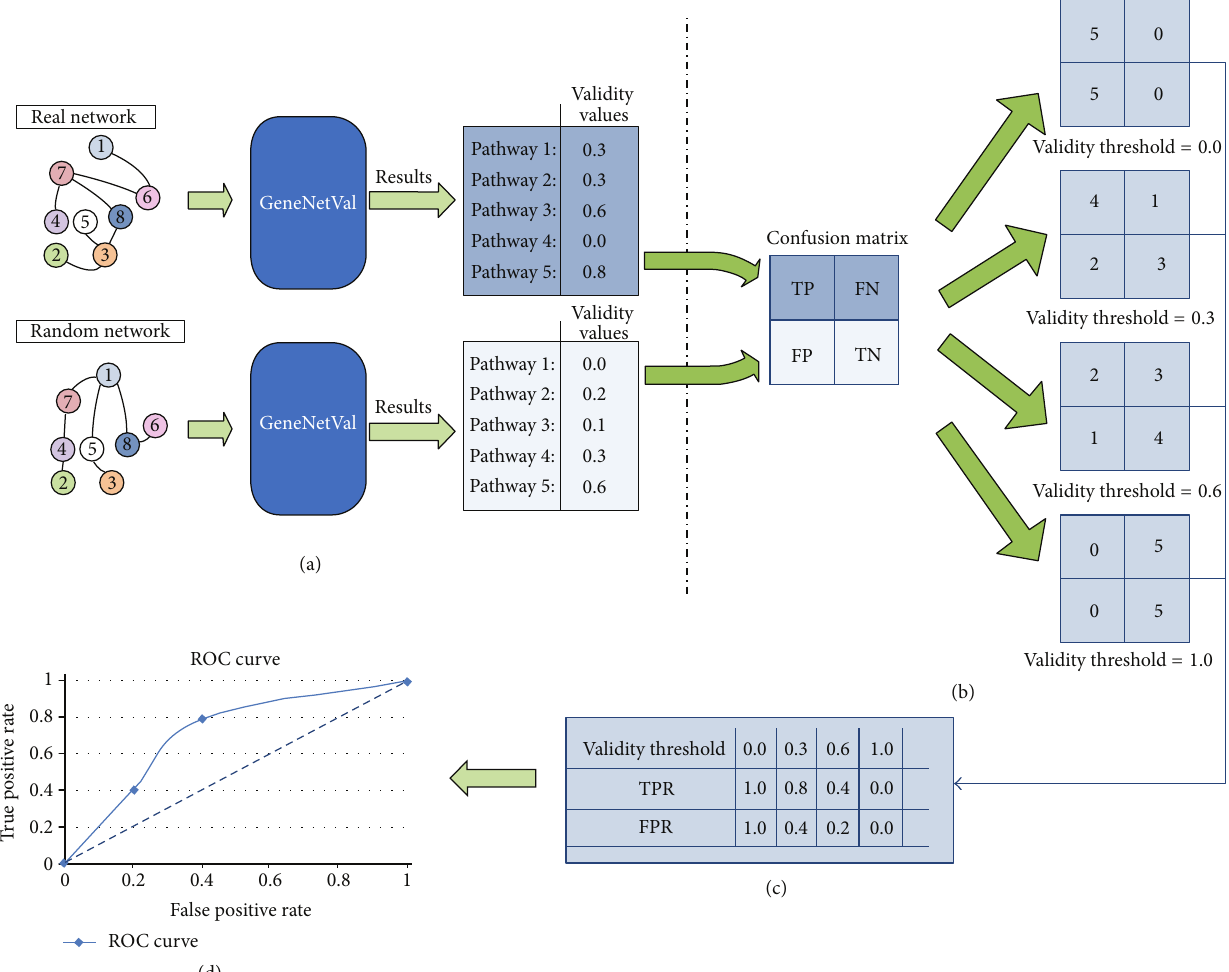
Figure 5: Representation of a toy example for the ROC study performed. (a) represents the GeneNetVal process, where the validity values for both networks are obtained. In (b) the confusion matrices are obtained. The TPR and FPR values are presented in (c). Finally the ROC curve is depicted in